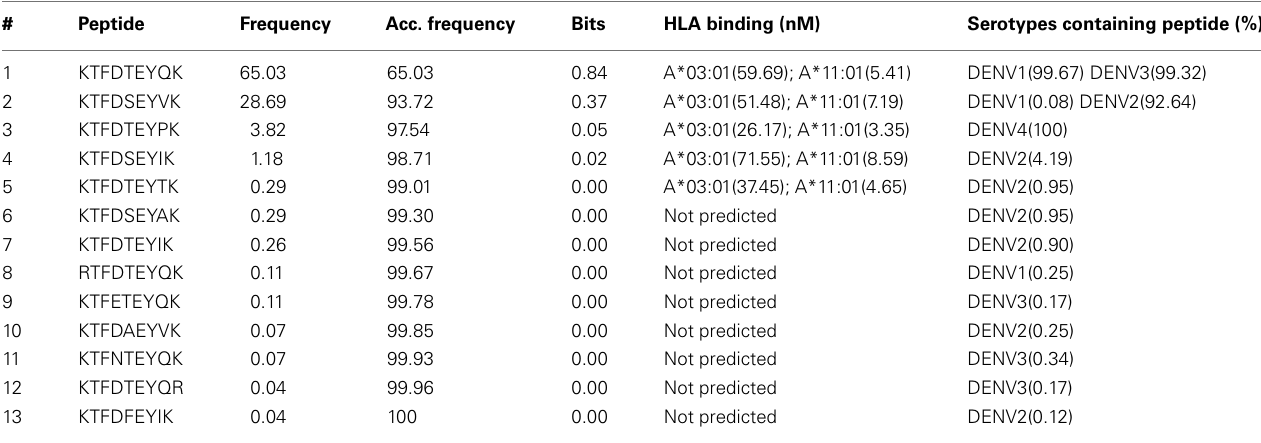
Table 3 | Details of the peptides observed in block 388 of the NS3 protein.